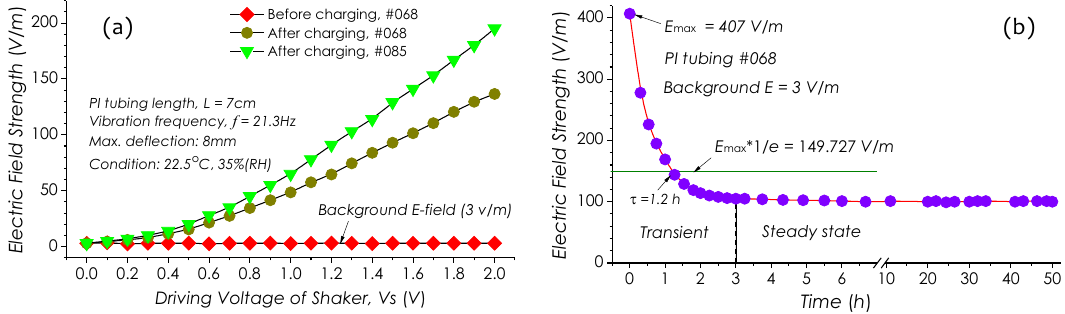
Figure 6. Results on charge E -field strengths measured with a proposed procedure. ( a ) Field strength vs. driving voltage of shaker and ( b ) charge E -field strength decaying with time.